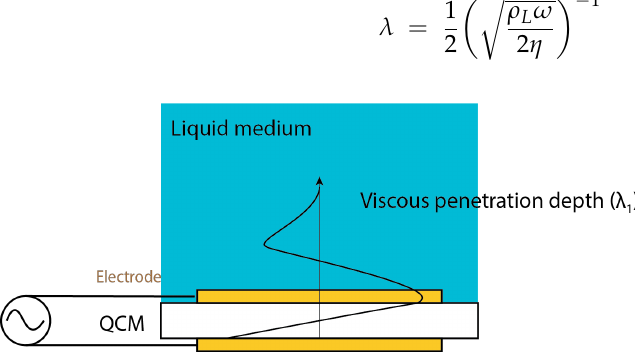
Figure 11. Penetration of QCM immersed in liquid